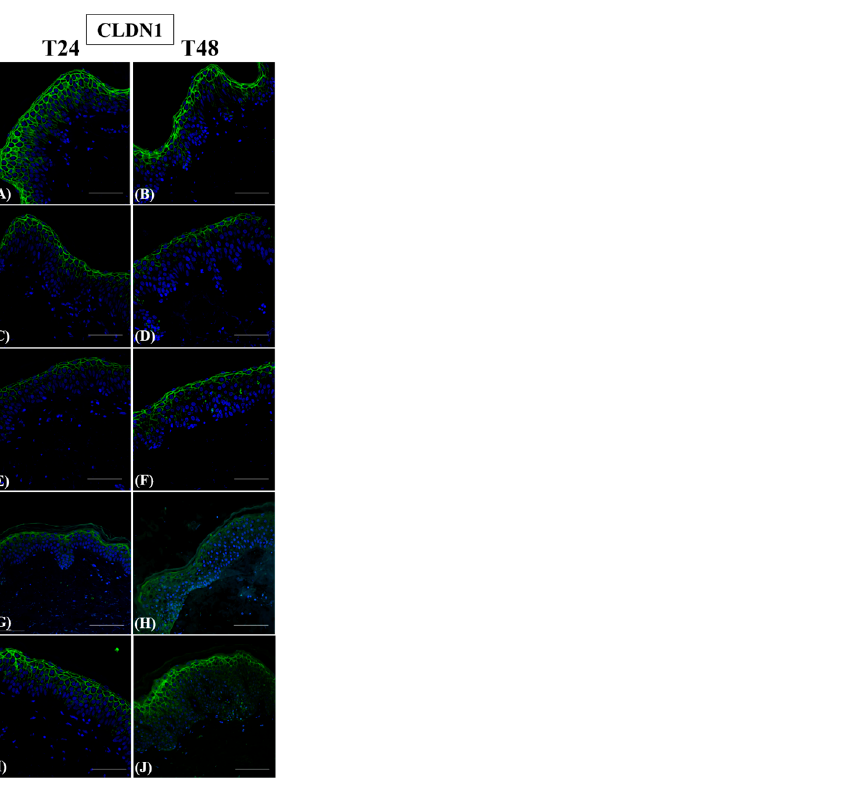
Figure 1. Immunofluorescence of claudin-1 expression on paraffin human skin sections. Representative claudin-1 immunostaining in normal human skin paraffin sections. ( A , C , E , G , I ): samples harvested at 24 h; ( B , D , F , H , J ): samples harvested at 48 h. ( A , B ): CTR samples; ( C , D ): IL-4-treated samples; ( E , F ): IL-13-treated samples; ( G , H ): IL-22-treated samples; ( I , J ): IL-23-treated samples. Nu- clei are counterstained with DAPI. CTR: control; IL-4: interleukin 4; IL-13: interleukin 13; IL-22: interleukin 22; IL-23: interleukin 23; DAPI: 4 (cid:48) , 6-diamidino-2-phenylindoledihydrochloride—scale bars: 50 µ